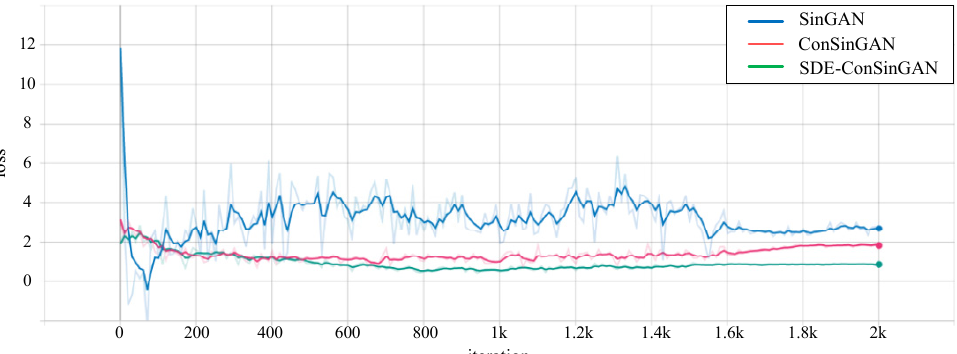
Figure 11. Loss comparison of three image-generation methods.